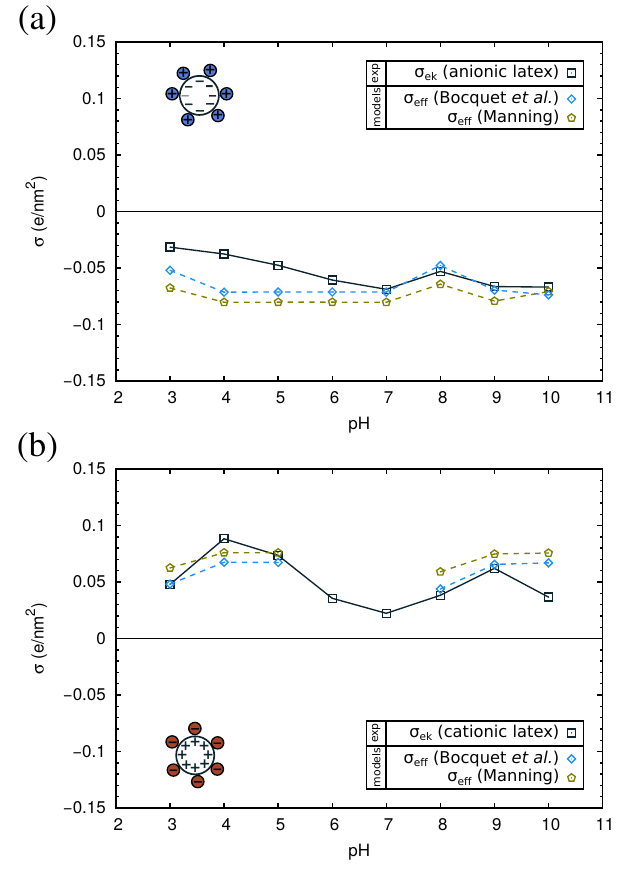
Figure 9. Electrokinetic charge ( σ ek ), obtained by Ohshima’s equation (Equation (5)), and effective charge ( σ ef f ) taking into account ion condensation (the Manning model and the Bocquet et al. model) for ( a ) anionic and ( b ) cationic latex. The solid and dashed lines are used for guiding the